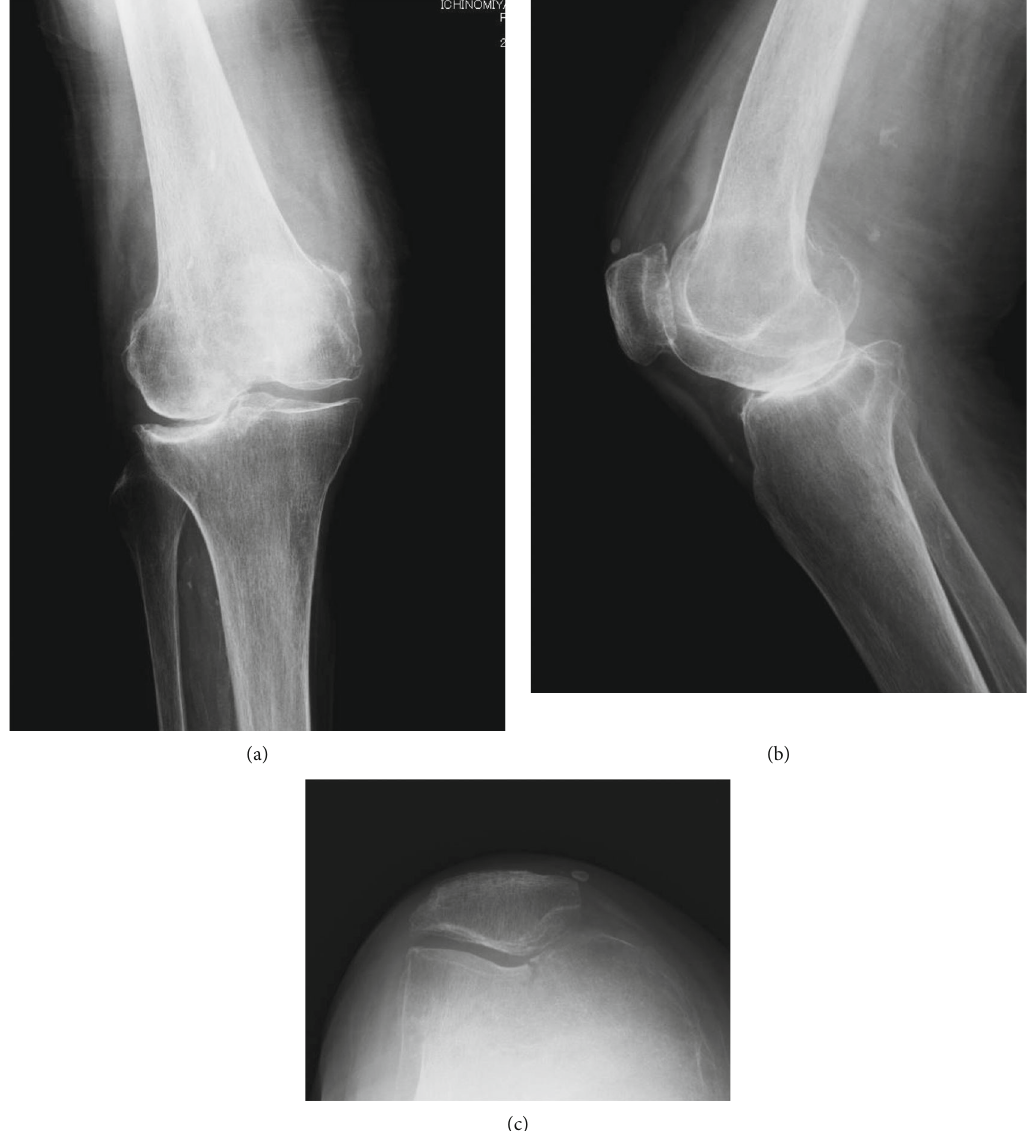
Figure 1: A 90-year-old female with a fracture of the distal femur with lateral knee osteoarthritis. (a) AP view, (b) lateral view, and (c) axial